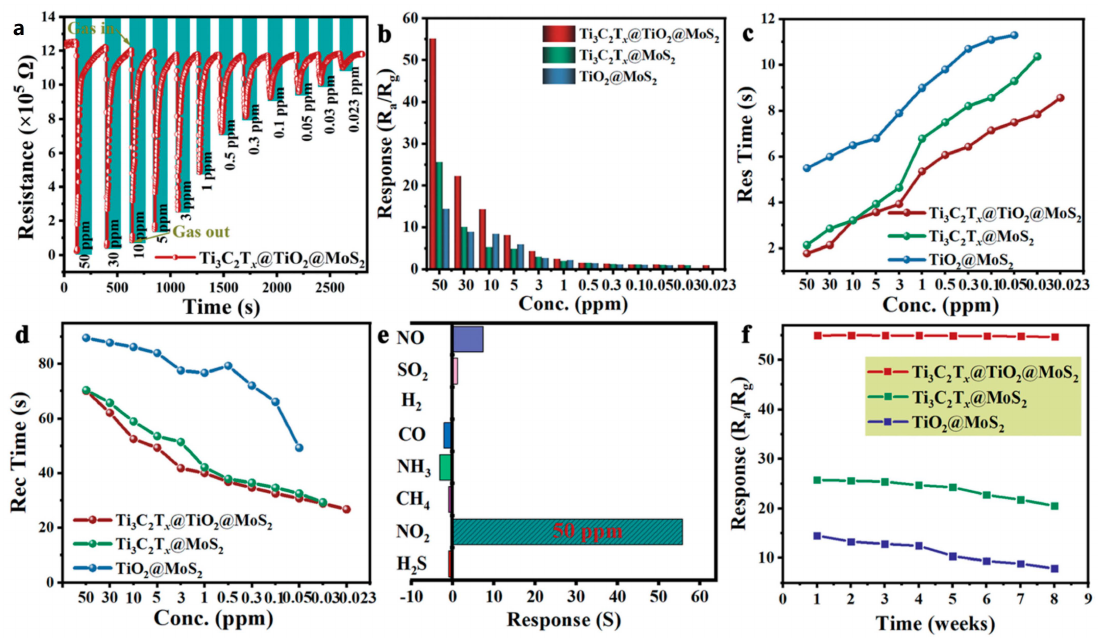
Figure 33. ( a ) Dynamic response curves of the Ti 3 C 2 T x /TiO 2 /MoS 2 sensor to NO 2 at RT (RH = 23.4%). ( b ) Response histogram of different sensors to NO 2 . ( c , d ) Response and recovery time curves of sensors. ( e ) Selectivity of Ti 3 C 2 T x /TiO 2 /MoS 2 toward various gases under the same conditions. ( f ) Stability of different sensors at 50 ppm NO 2 . Reprinted with permission from [151]. Copyright 2022: The Royal Society of